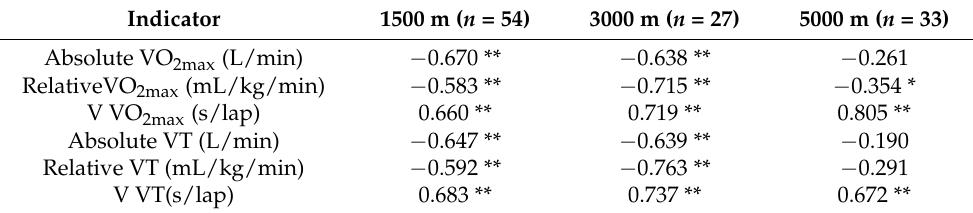
Table 6. Correlation between OIST and Personal Best in 1500 m, 3000 m, and 5000 m. Indicator